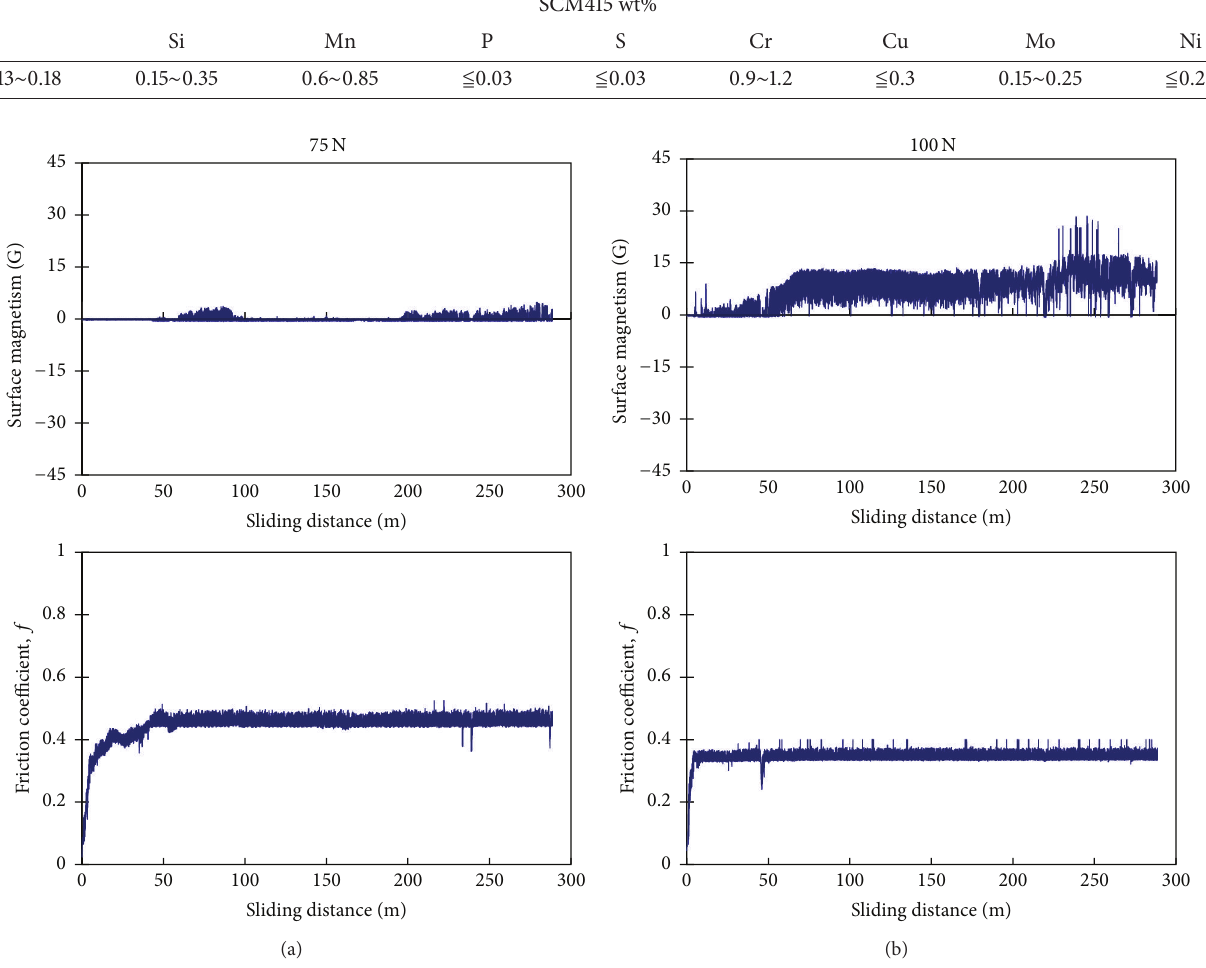
Figure 3: Surface magnetization and friction coefficient responses for SCM415 with Carburizing-Tempering: (a) 75 N and (b) 100 N.